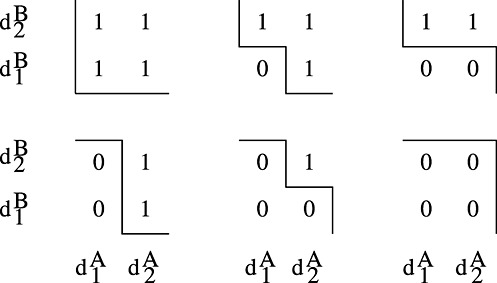
The six monotonic MTCθ for two drugs, each with two experimental dose levels.